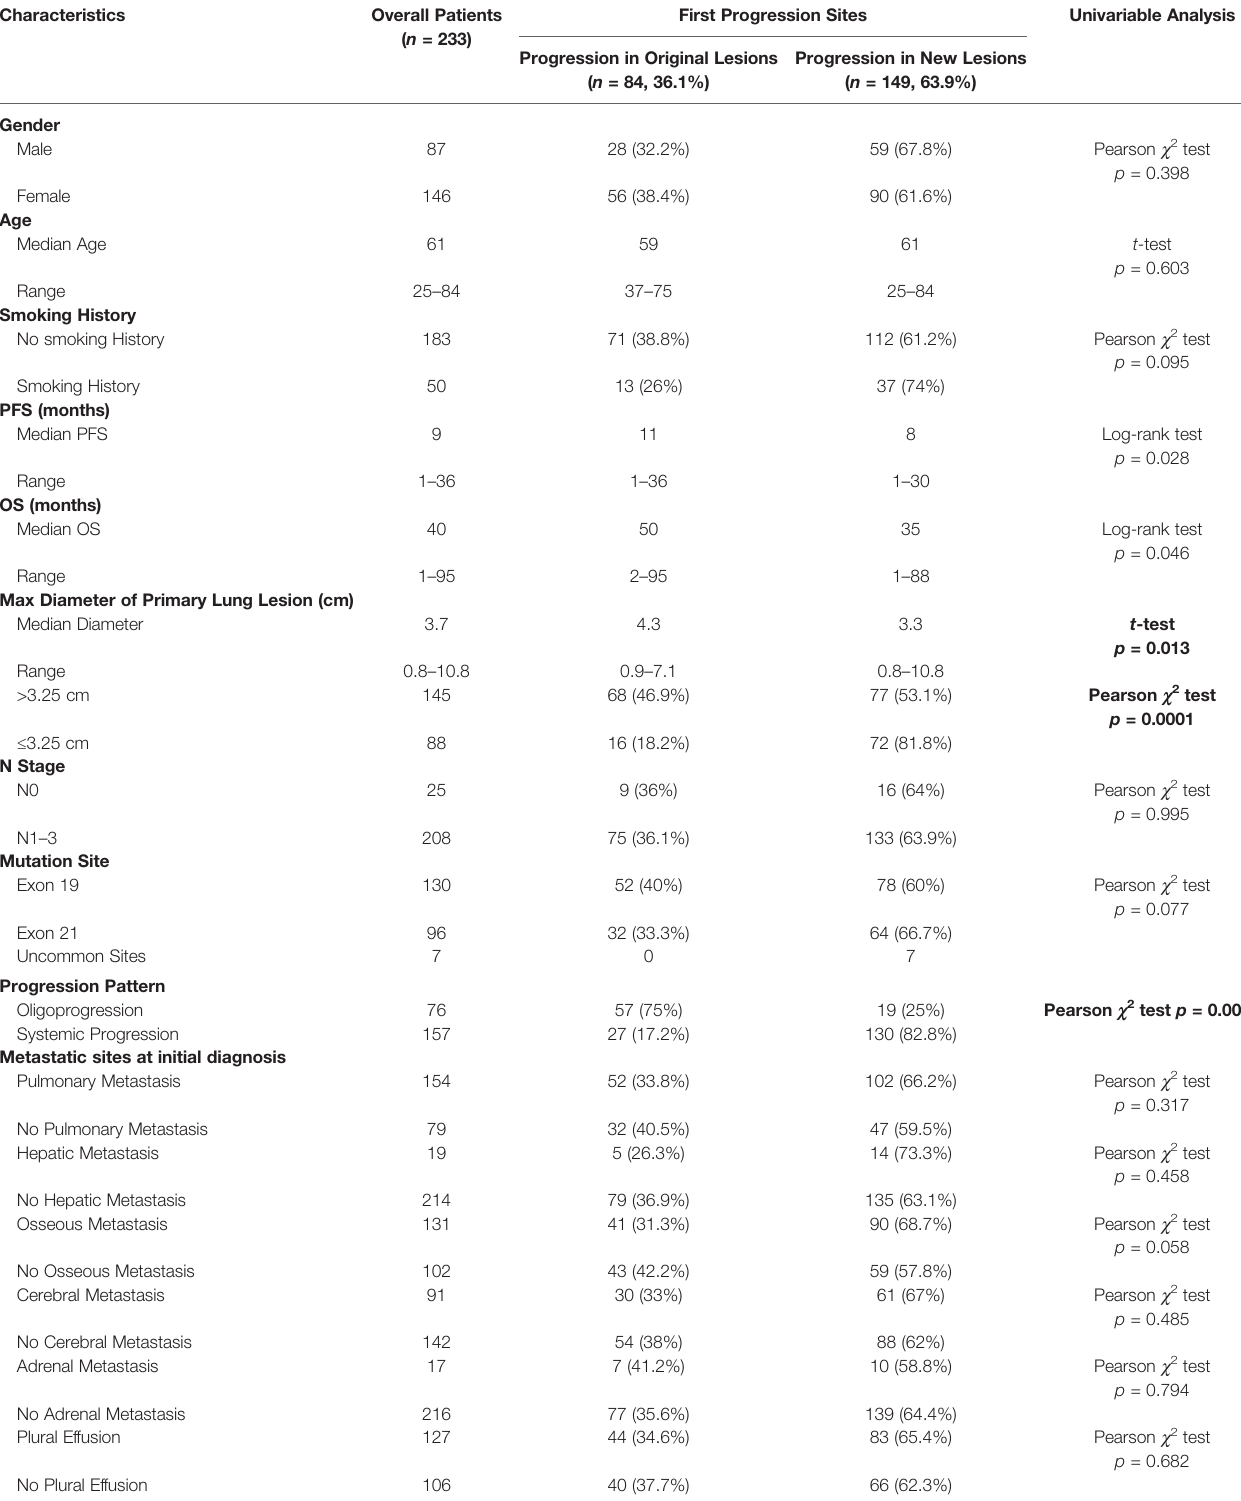
TABLE 1 | Comparison of clinical characteristics of patients with progression in original lesions and progression in new